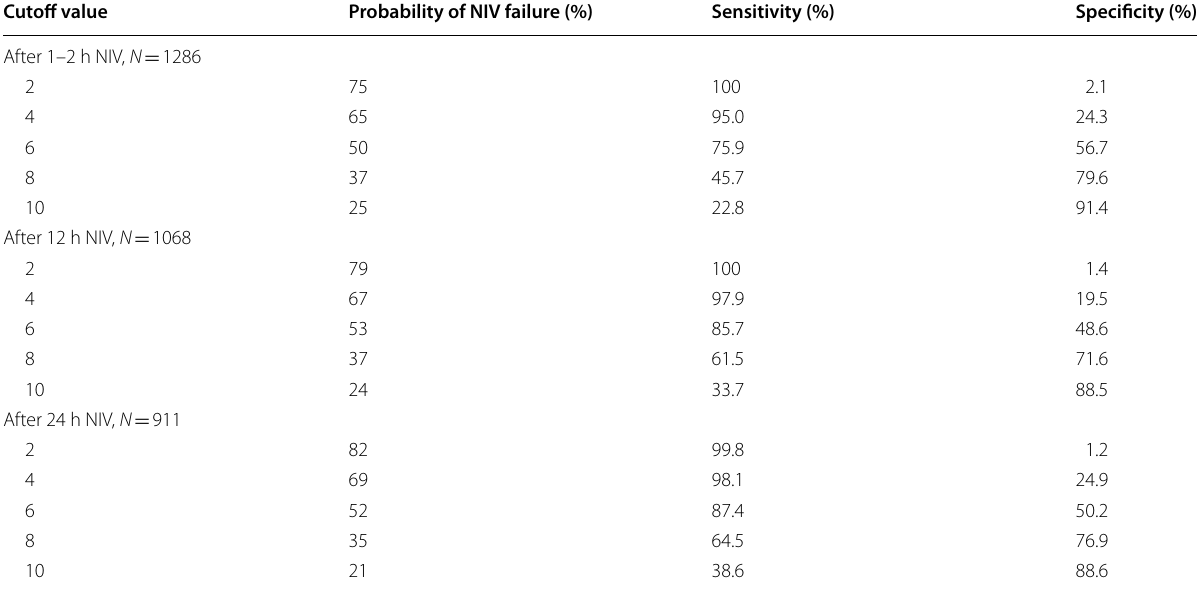
NIV noninvasive ventilation, ROX ratio of SpO 2 /FiO 2 to respiratory rate